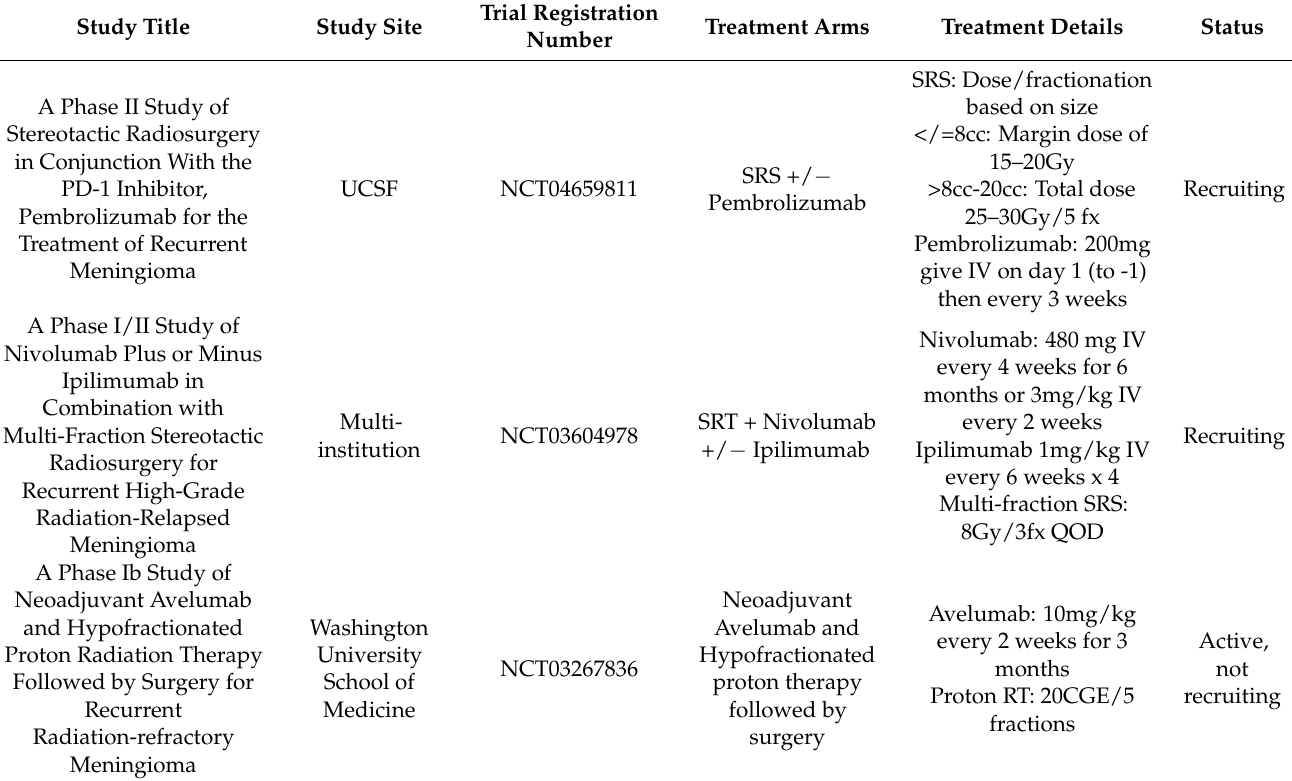
Table 1. Ongoing clinical trials combining radiation with ICIsin